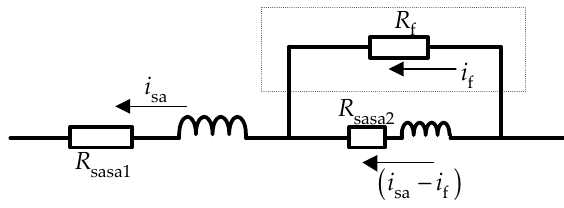
Figure 2. Representation of the stator winding inter-turn short branch.